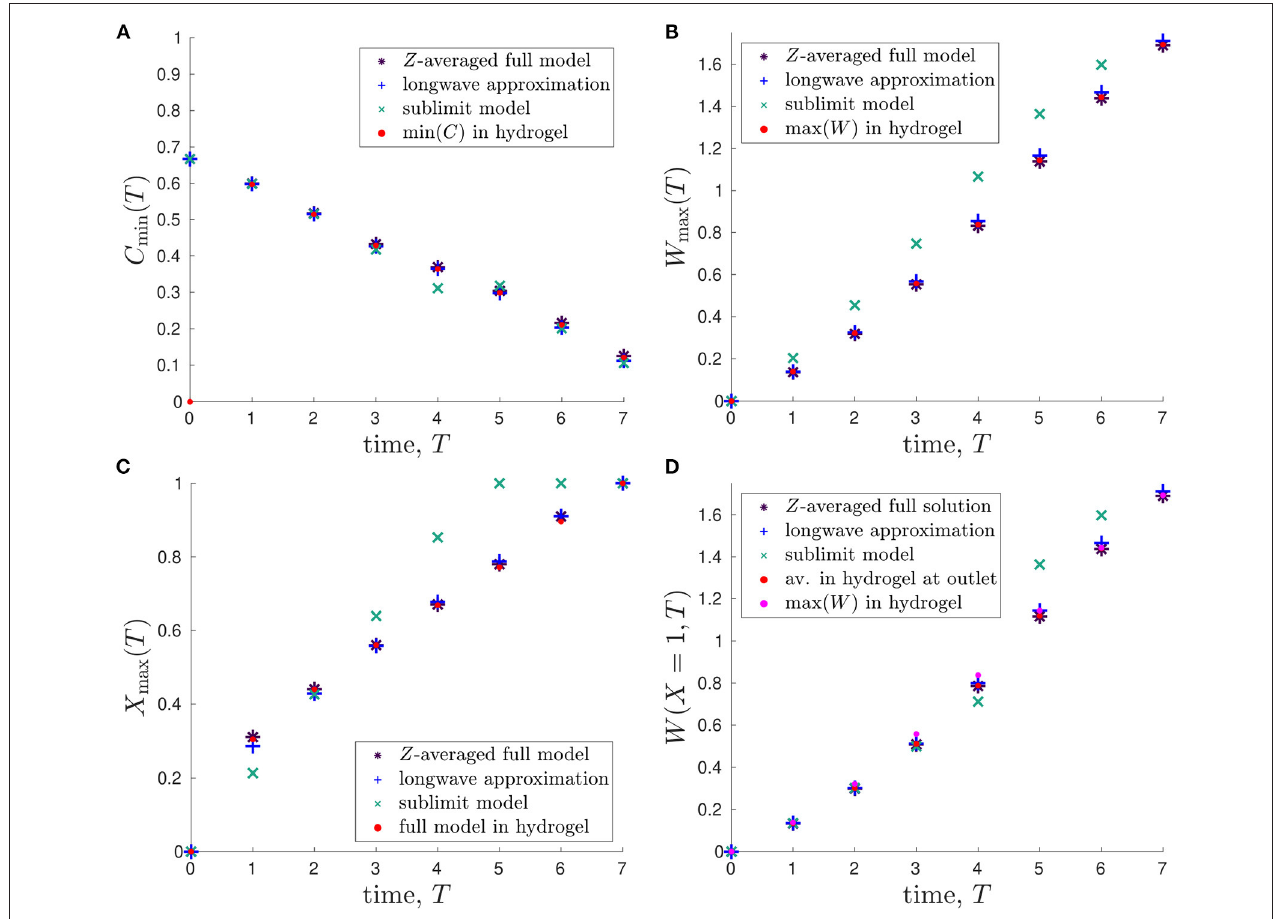
FIGURE 5 | Comparison of outputs from the different mathematical models and their evolution in time: (A) minimum glucose concentration, C min ( T ); (B) maximum lactate concentration, W max ( T ); (C) spatial position of maximum lactate concentration, X max ( T ) s.t. W ( X max , T ) = W max ( T ); (D) lactate concentration at outlet of bioreactor, W ( X = 1, T ). The red points represent the values predicted in the hydrogel region of the full 2D model. Parameter values: see Table 3